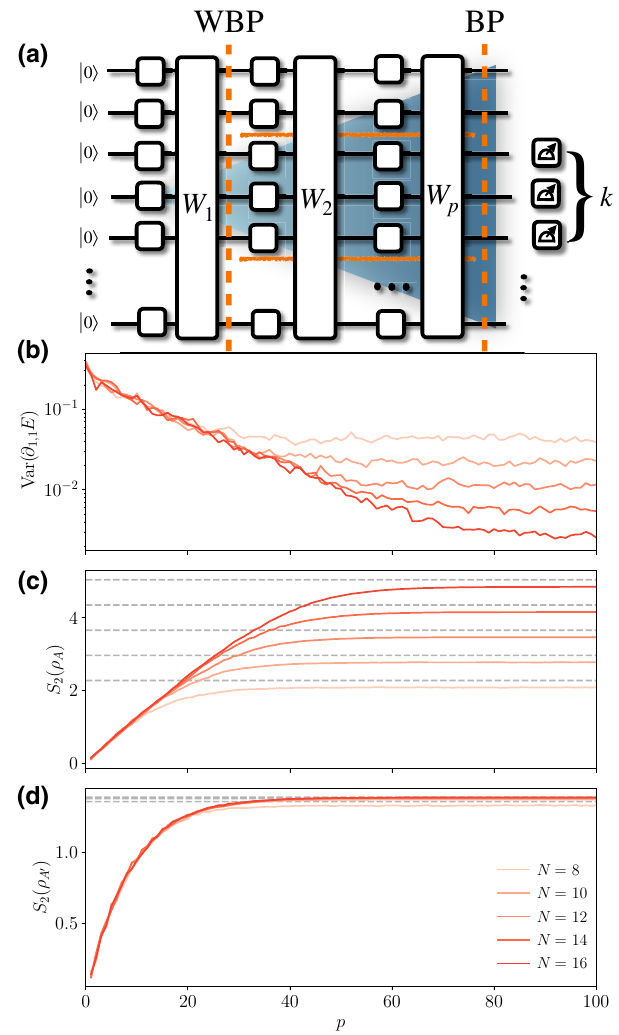
FIG. 2. (a) Sketch of the circuit, where the blue color shows the scrambling lightcone. The lightcone first extends over k qubits, where the WBP occurs, and for larger circuit depths extends to the full system size where the BP occurs. (b) The sat- uration of the gradient variance Var[ ∂ 1,1 E ] and (c) saturation of the bipartite second Rényi entropy S 2 (ρ A ) of the region A con- sisting of qubits 1, . . . , N / 2 nearly to the Page value happen at the similar circuit depths p , that increases with the system size N . (d) In contrast, the saturation of the second Rényi for two qubits ( A (cid:12) = { 1, 2 } ) is system-size independent, illustrating that WBP precedes the onset of a BP. Data is averaged over 100 ran- dom initializations. Gradient variance is computed for the local σ z , typically used in BP illustrations. Gradient variance term σ z 1 2 for the full Heisenberg Hamiltonian, Eq. (2), looks similar. FIG. 3. (a) Decreasing parameter (cid:11) θ from 1 slows down the